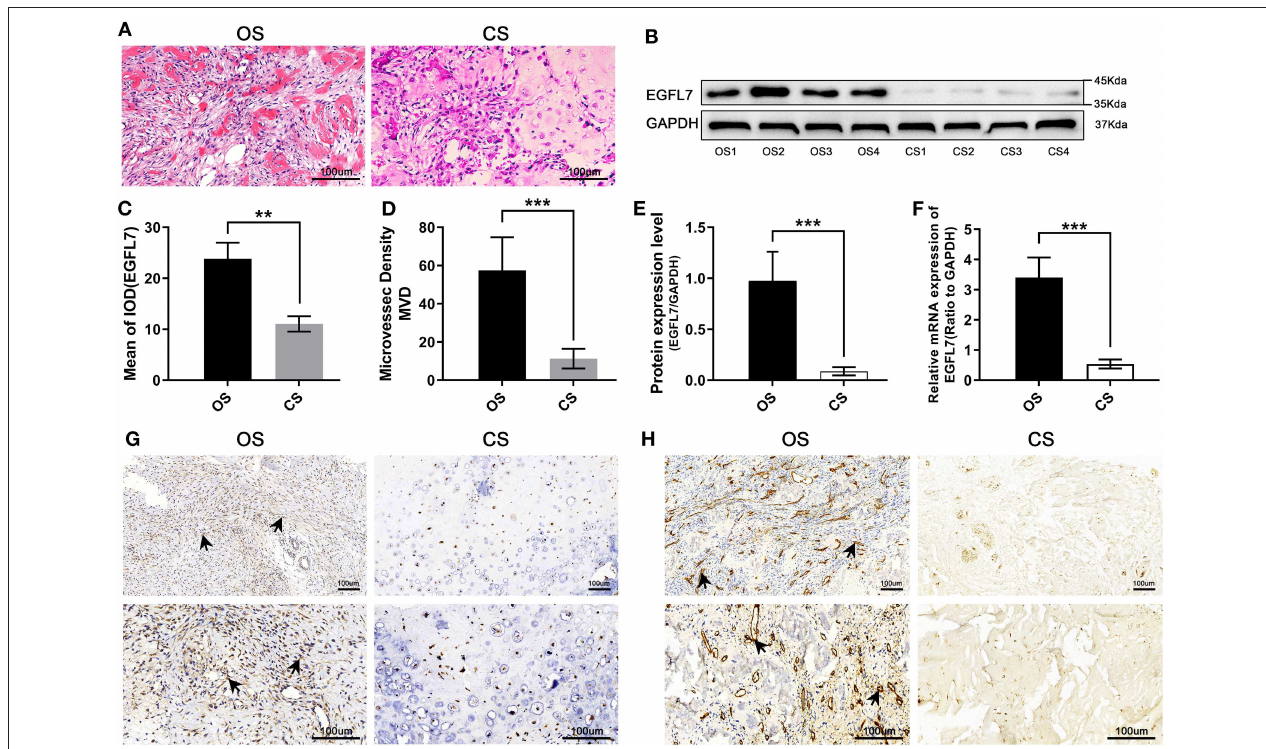
FIGURE 1 | Compared with CS, EGFL7 is highly expressed in OS. (A) Typical pathological features of OS and CS revealed by HE staining, tumor-like osteogenesis can be seen in OS and cartilage-like matrix in CS. (B,C) Immunohistochemical of EGFL7 protein expression in OS tissue ( n = 2) and CS controls ( n = 2), comparison of IHC results from different magnification (100 and 200 × ) and its significance. High expression of EGFL7 ( ++ ) was found in OS tissues but negative in CS, the arrow refers to the positive area. The semi-quantitative statistical analysis based on IHC results shows that there is a significant difference in the expression of EGFL7 protein between OS and CS. (D,E) Western blot results showed that EGFL7 protein was overexpressed in OS tissue compared with CS, Student’s t -test shows that the difference between OS and CS has obvious statistical significance. The abundance of EGFL7 protein in OS tissue was similar to that of GAPDH protein. (F) RT-PCR results showed that the transcription level of EGFL7 mRNA in OS tissues was significantly higher than that in CS tissues, and the difference was statistically significant. (G) Immunohistochemical results of chondrosarcoma and osteosarcoma showed that EGFL7 was highly expressed in osteosarcoma. (H) The